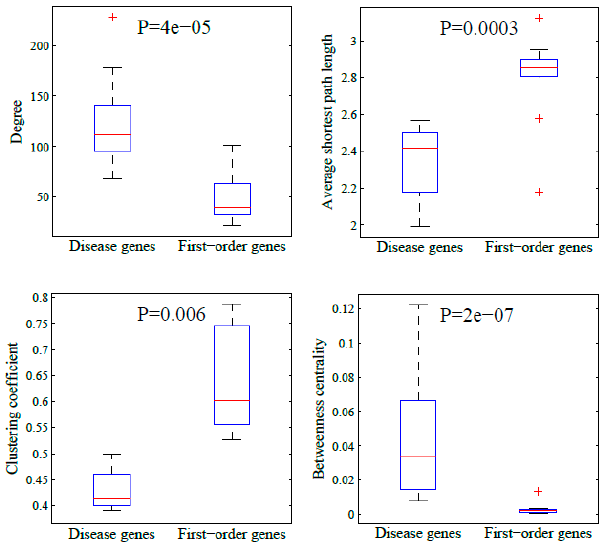
Figure 5. The comparison of the four network parameters in the top-ten popular genes and those in their first-order neighbor genes.